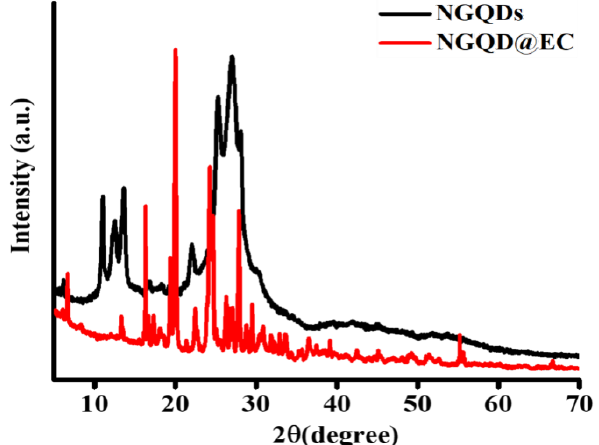
Figure 4. X-ray Diffraction pattern (XRD) of NGQDs and NGQD@EC.